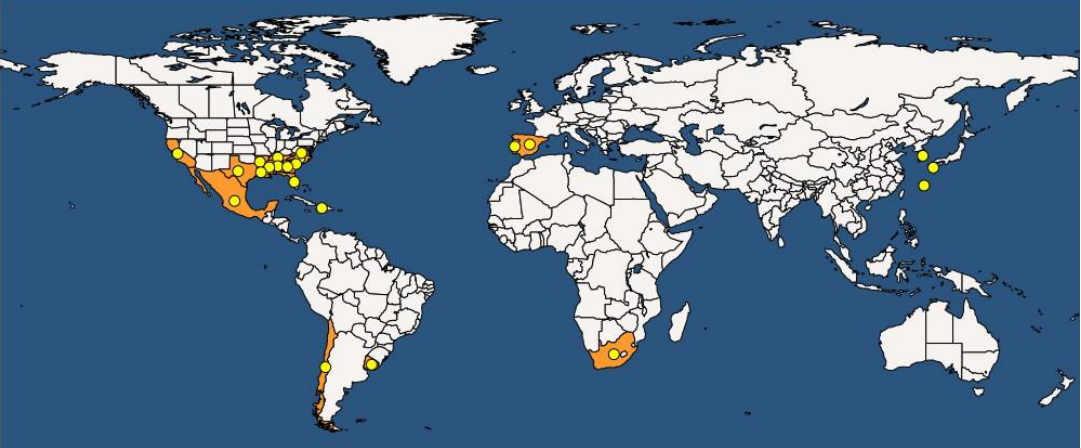
Figure 2. World map of the current distribution of Fusarium circinatum represented by yellow dots [50].